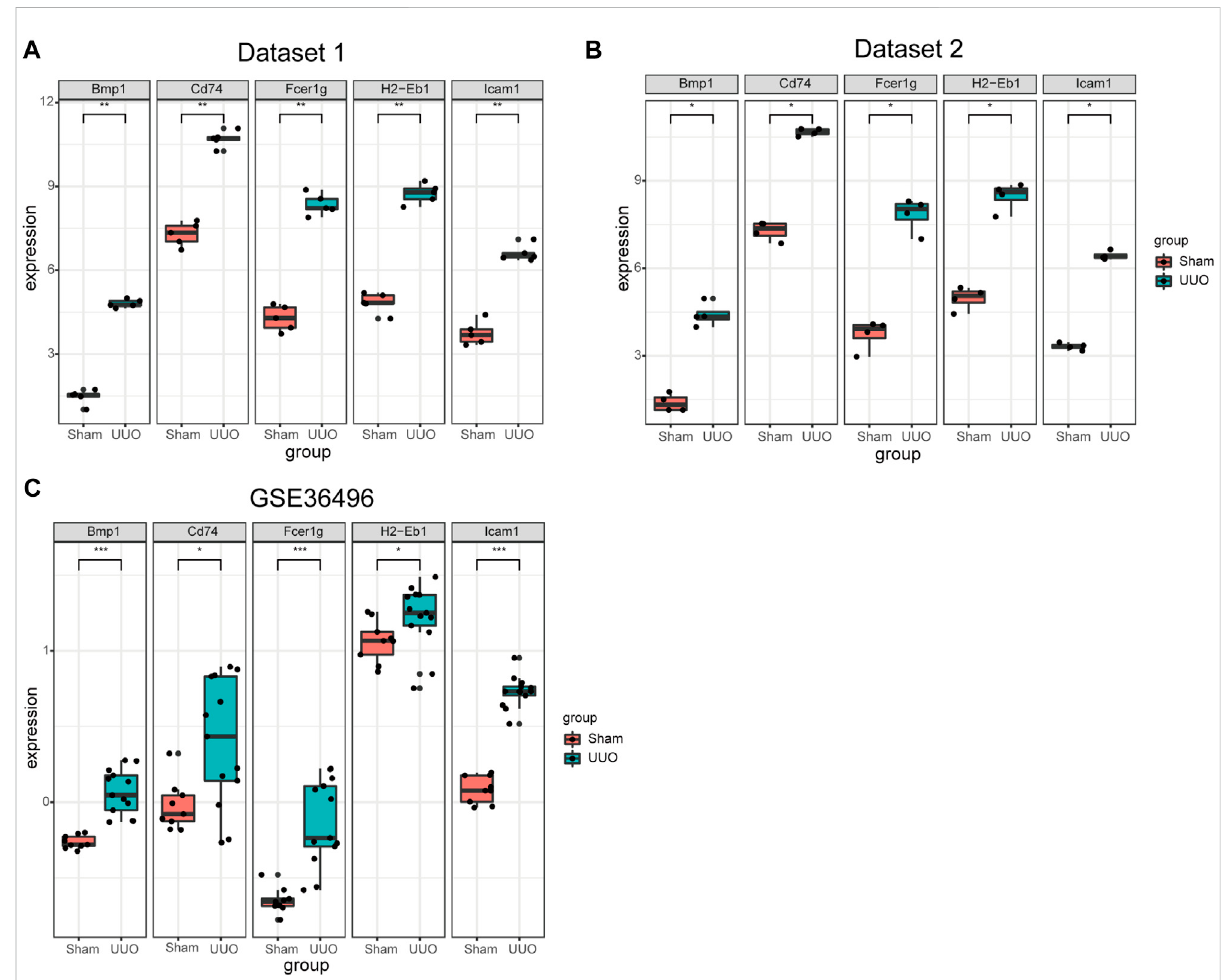
FIGURE 5 The expression of the fi ve hub genes in three datasets. (A) The expression of the fi ve hub genes in dataset 1. (B) The expression of the fi ve hub genes in dataset 2. (C) The mRNA expression level of the hub genes in dataset GSE36496. * p < 0.05, ** p < 0.01, *** p <